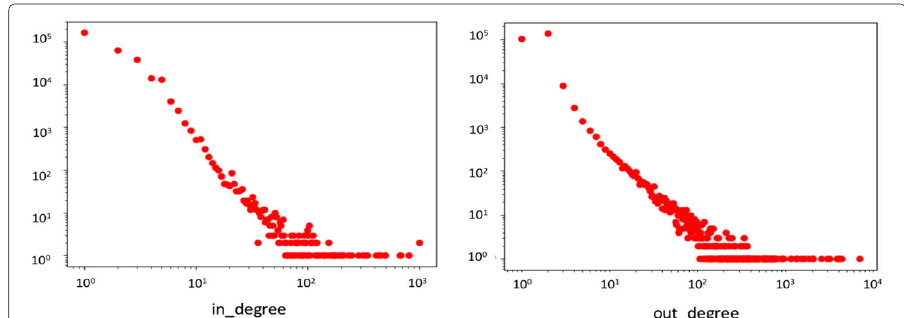
Fig. 2 In-degree and out-degree distributions of the unlabeled, directed Panama multi-network. Using a method first proposed in Clauset et al. (2009) (briefly summarized in the main text), we estimated the in-degree and out-degree power-law coefficients to be 3.315 and 2.186